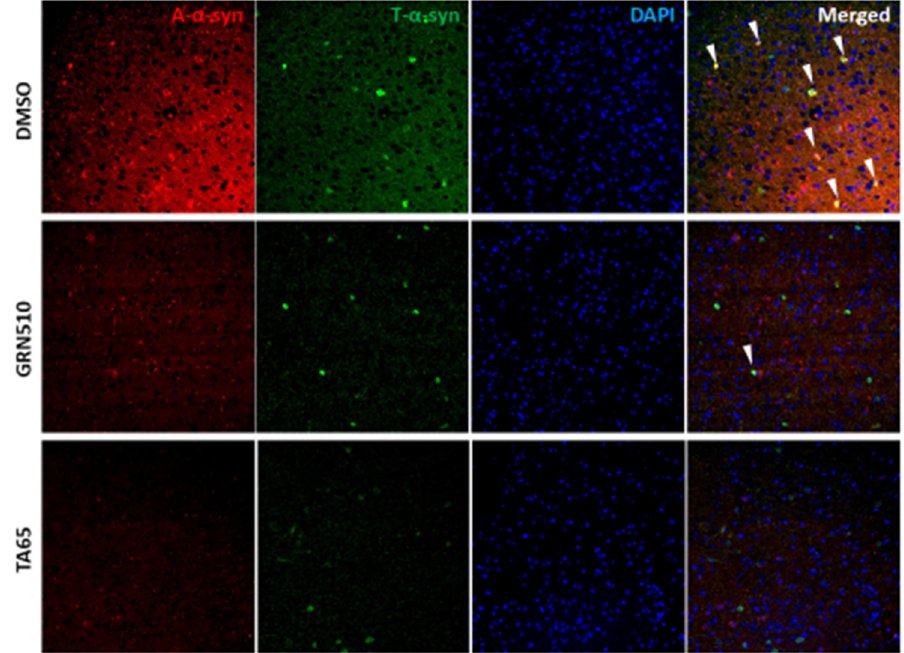
Figure 2. Aggregated (red signal) and total (green signal) human α -synuclein in the neocortex of DMSO-treated (control), GRN510 and TA-65 treated mice. The white arrowheads show a yellow merged signal of neurons with aggregated on top of total α -synuclein. Blue DAPI staining of nuclei. For details and quantification, see [67].